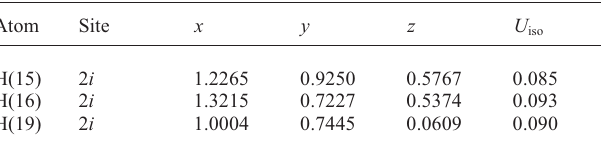
Table 3. Atomic coordinates and displacement parameters (in Å 2 )